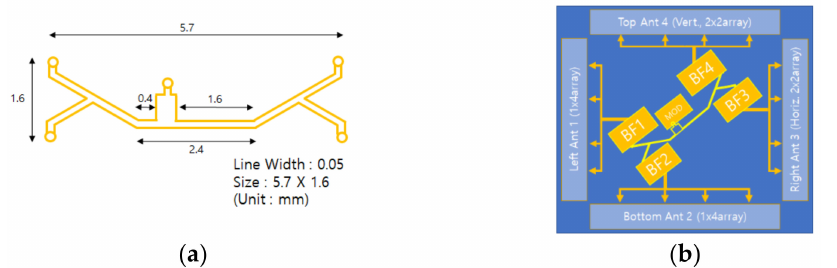
Figure 9. ( a ) Layout and parameters of the designed 1 × 4 divider, and ( b ) the concept of the package. Bottom layer designed with the asymmetric 1 × 4 divider.